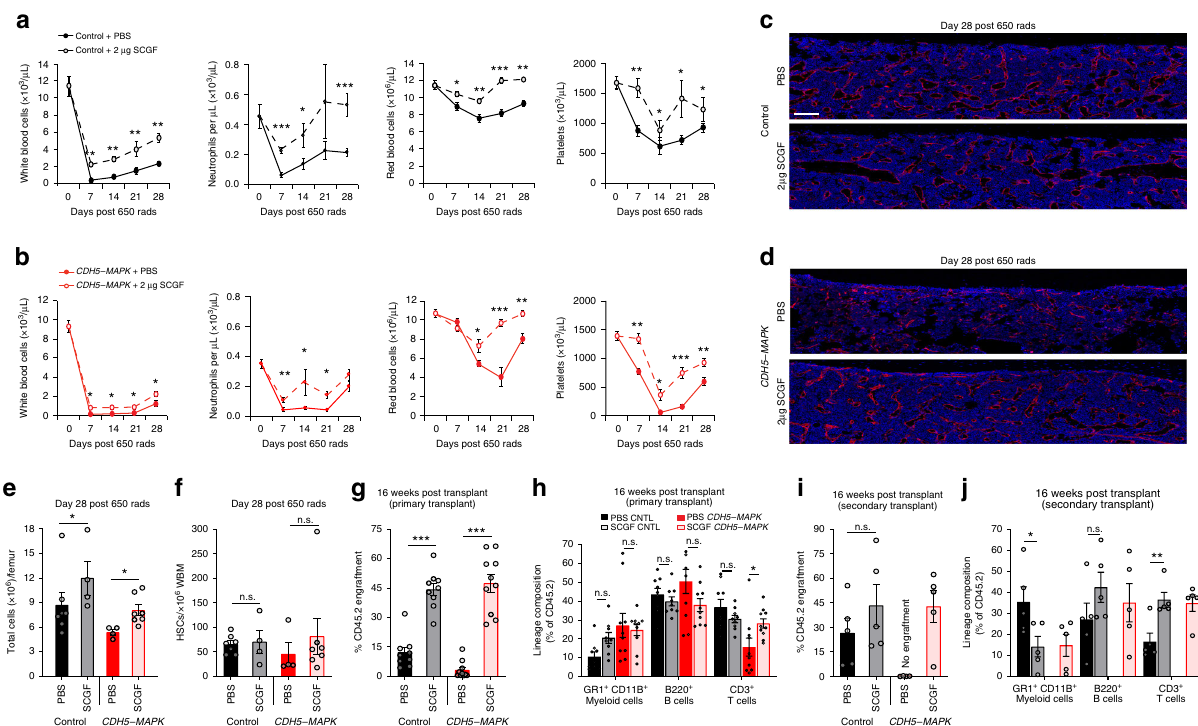
Fig. 9 SCGF enhances hematopoietic regeneration following myelosuppressive injury. a , b Following 650 rad of irradiation, 2 μ g of SCGF was infused on alternate days into control and CDH5-MAPK mice for a total of seven injections starting at Day + 1 and hematopoietic recovery was assessed for 28 days. SCGF infusion promoted a signi fi cant increase in white blood cell, neutrophil, red blood cell, and platelet recovery at indicated time points in a control mice ( n = 6 – 7 mice/cohort) as well as b CDH5-MAPK mice ( n = 7 – 8 mice/cohort). c , d Representative immuno fl uorescence images of femurs intravitally labeled with a vascular-speci fi c CD144/VEcadherin antibody (red) at 28 days following irradiation demonstrating that SCGF infusion improved vascular recovery in both c control mice as well as d CDH5-MAPK mice. e Total cells per femur ( n = 4 – 7 mice/cohort). f Frequency of phenotypic HSCs per 10 6 femur cells assessed by fl ow cytometry ( n = 4 – 7 mice/cohort). g , h Competitive repopulation assays assessing total CD45.2 + cell engraftment and CD45.2 + lineage distribution of donor WBM cells. Donor cells were isolated 28 days post-irradiation from PBS/SCGF-treated control and CDH5-MAPK mice. 2.5 × 10 6 donor WBM cells (CD45.2) were transplanted with 5 × 10 5 competitor WBM cells (CD45.1) into pre-conditioned CD45.1 recipient mice ( n = 9 – 10 recipients/cohort; n = 5 donors per cohort). i , j Secondary transplantation assay wherein WBM cells from long-term engrafted primary recipients were isolated and transplanted into pre-conditioned CD45.1 recipient mice. 2 × 10 6 donor WBM cells were transplanted per secondary recipient ( n = 4 – 5 recipients/cohort; n = 5 donors per cohort). Error bars represent sample mean ± SEM. Statistical signi fi cance was determined using two-tailed unpaired Student ’ s t -test. * P ≤ 0.05; ** P < 0.01; *** P < 0.001; n.s. P >